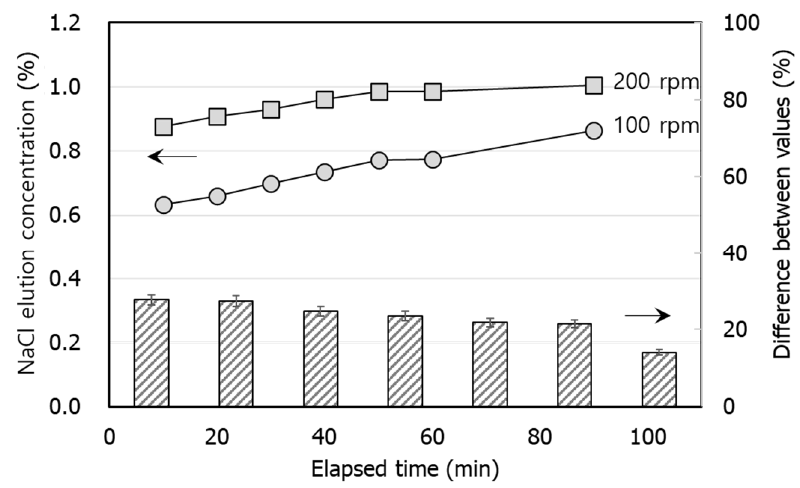
Figure 3. NaCl elution concentration ( left arrow ) with elapsed time at B-OWR3 with different mixing speeds. The bar chart is difference between values 100 rpm and 200 rpm ( right arrow ) with elapsed time at B-OWR3.